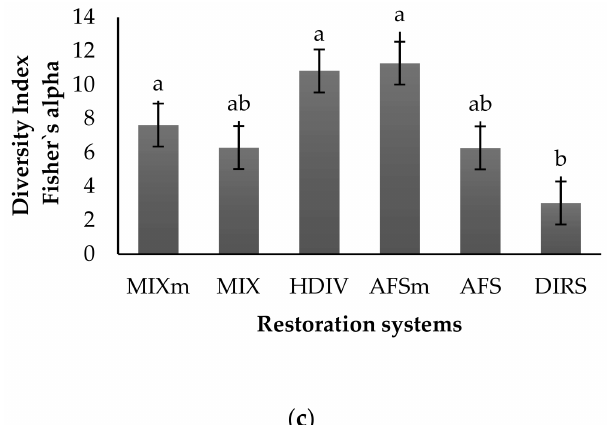
Figure 3. E ff ects of di ff erent restoration systems for tropical semi-deciduous forest on species richness and diversity, 19–20 years after planting (pooled for sites). ( a ) Rarefaction curves for each restoration system, using the bootstrap method. The curves indicate the number of accumulated species as a function of the number of sampled individuals, by interpolation, with a confidence interval of 95%. The dotted lines indicate the error and the straight lines the interpolation points of rarefaction curves. ( b ) Total number of sampled species per system and the proportion of planted species, regenerating autochthonous and allochthonous species. ( c ) E ff ect of restoration system on the Fisher’s Alpha diversity index. Labels: MIXm (‘managed’ commercial mixed plantation), MIX (commercial mixed plantation), HDIV (high-diversity tree plantation), AFSm (‘managed’ agroforestry system), AFS (agroforestry system), DIRS (direct seeding). Bars represent average and standard error. Results for pooled sites data. Treatment means labelled with the same letters are not statistically di ff erent at 5% probability level (Tukey’s